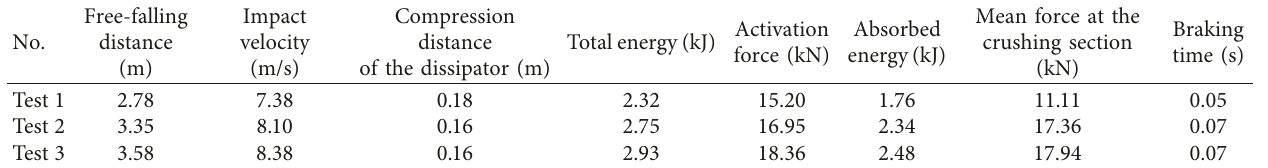
Table 5: Parameters of the tube-crushing dissipators in the dynamic tests.